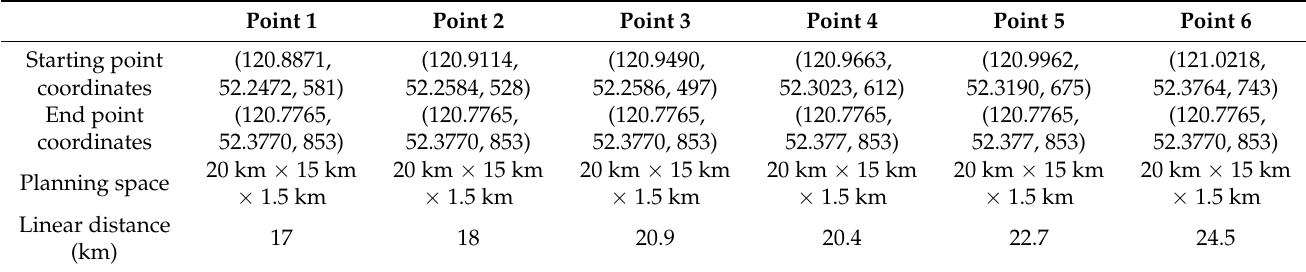
Table 1. Experimental parameters setting.